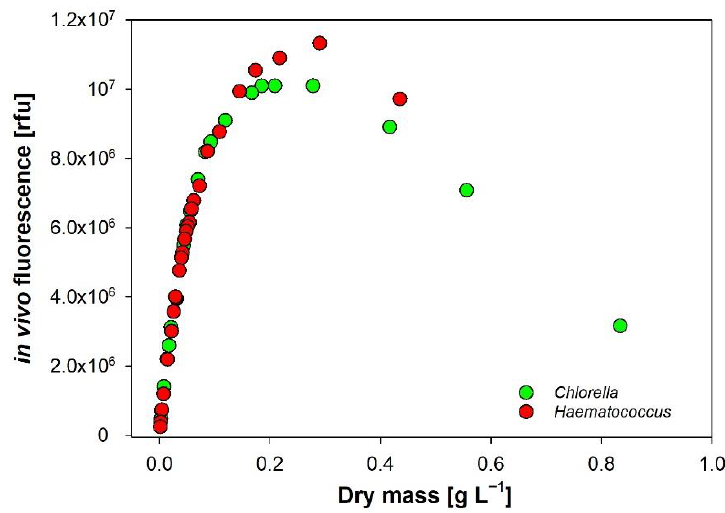
Figure 7. Dilution series of two commercially exploited chlorophytes Haematococcus and Chlorella (instrument HORIBA Fluorolog-3). The correlation at low to medium cell densities is linear, followed by a saturation and a drop of the fluorescence signal at high and maximum densities, respectively.